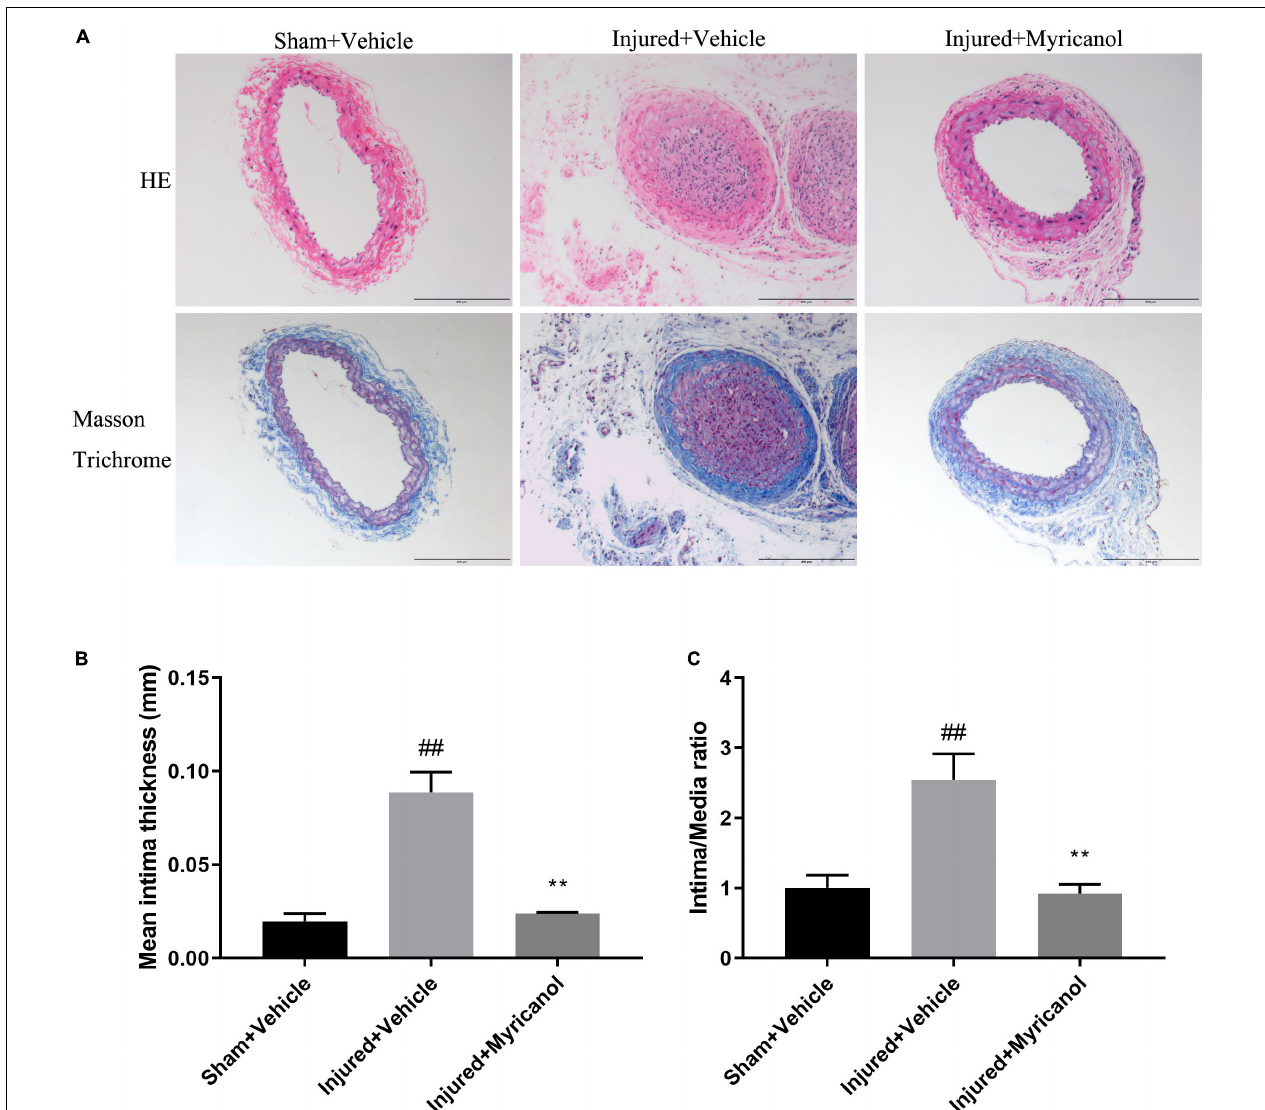
FIGURE 5 | Effect of myricanol on carotid artery ligation induced neointimal hyperplasia for 14 days. (A) myricanol (5 mg/kg/day) or hydration medium (PEG 400) was intraperitoneally injected for 14 days after carotid artery ligation. H&E-stained and elastic Masson trichrome-stained sections of all groups were shown. Scale bar, 200 µ m. (B) Quantification of the mean intimal thickness. Data are represented as mean ± SEM ( n = 3). ## P < 0.01 vs. the Sham + Vehicle group. ** P < 0.01 vs. the Injured + Vehicle group. (C) Quantification of the ratio of intima to media (I/M ratio). Data are represented as mean ± SEM ( n = 3). ## P < 0.01 vs. the Sham + Vehicle group. ** P < 0.01 vs. the Injured + Vehicle